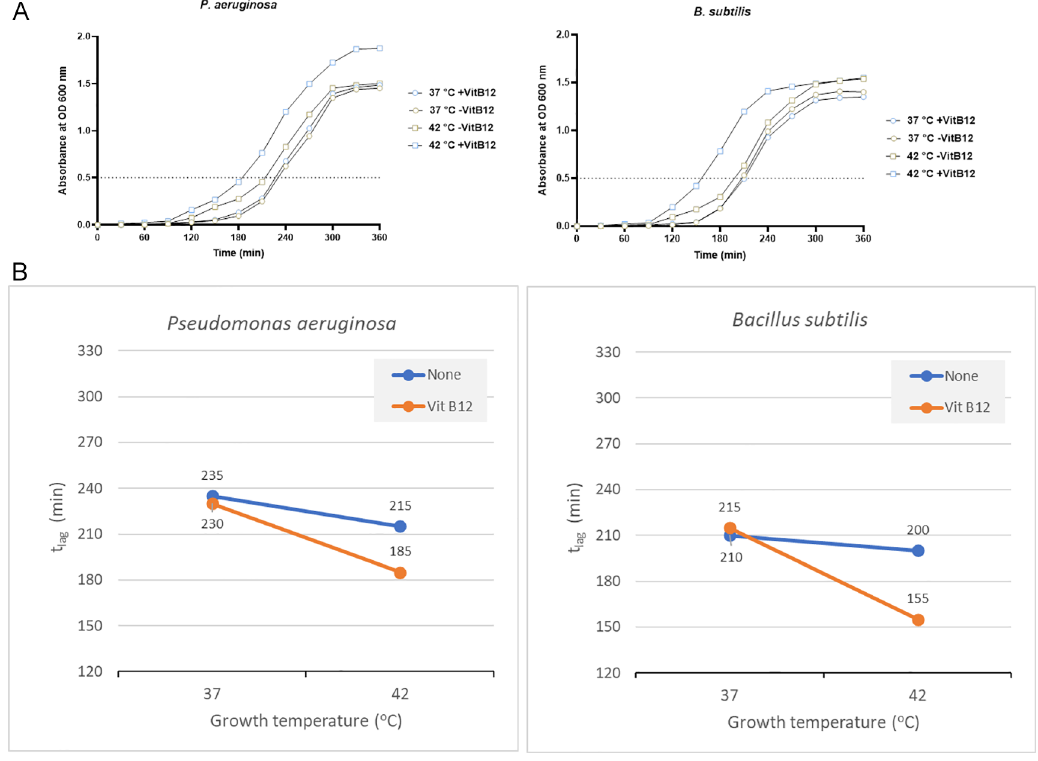
Figure 5. Results for Pseudomonas aeruginosa and Bacillus subtilis under different growth conditions, including temperature and vitamin B12 supplementation. (A) Growth curves of P. aeruginosa and B. subtilis were obtained in two-factorial designs, at 37 ° C and 42 ° C, with and without vitamin B12. The dotted line indicates OD 0.5 for estimating the t lag from curves. (B) Effect plot of P. aeruginosa and B. subtilis in minutes (t lag ) to reach optical density 0.5.